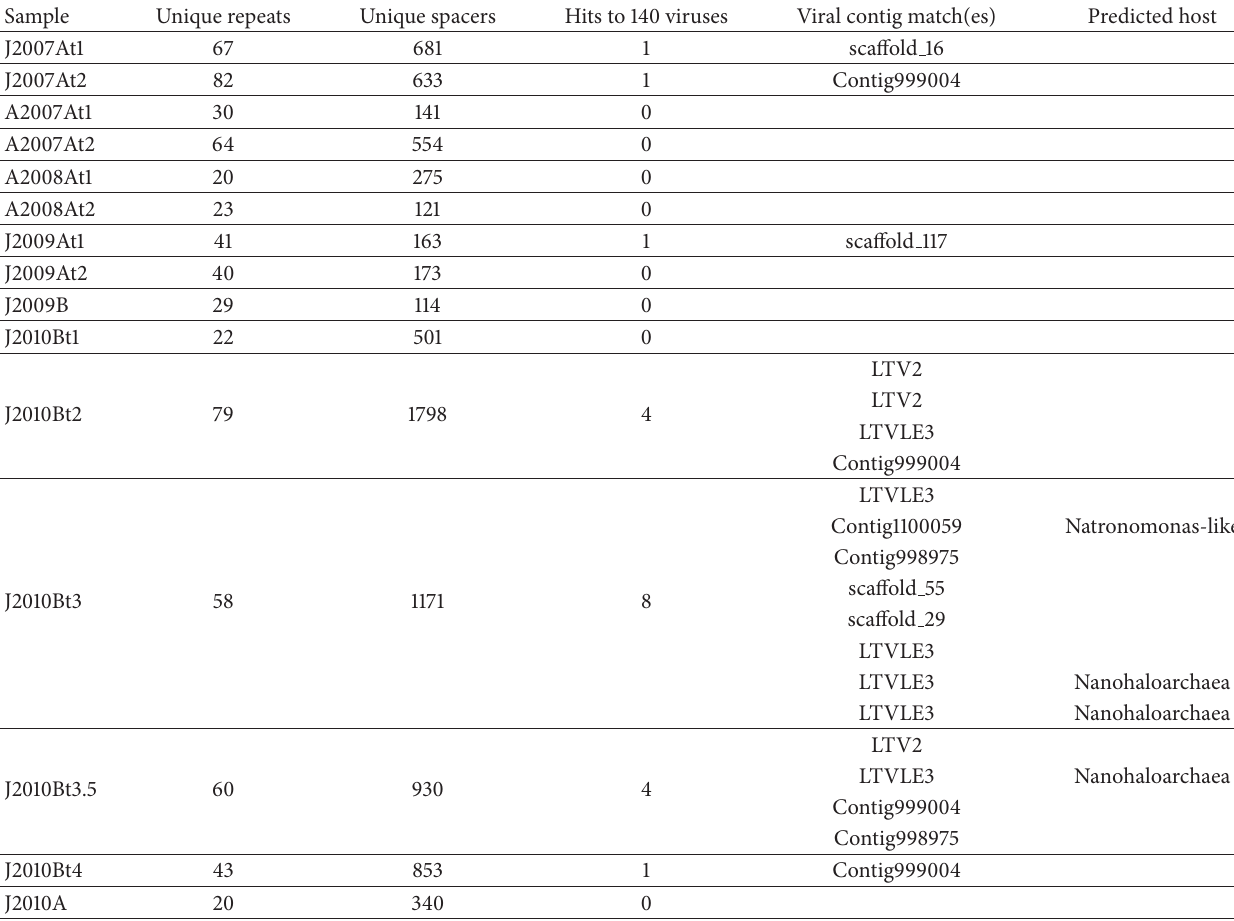
Table 2: CRISPR analyses by